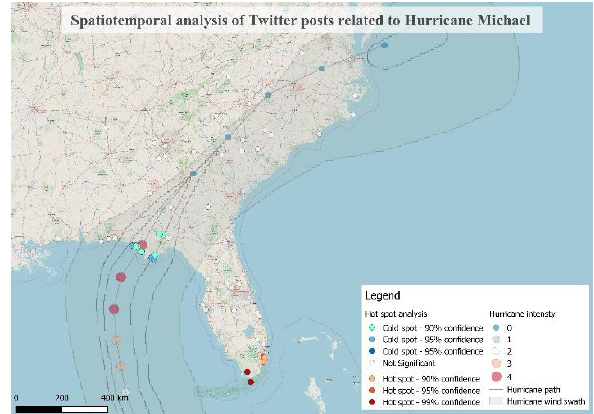
Figure 6. Hot spot analysis of Twitter posts (cold spots present concentration of posts published at the beginning of event; hot spot present concentration of posts published on the last days of the